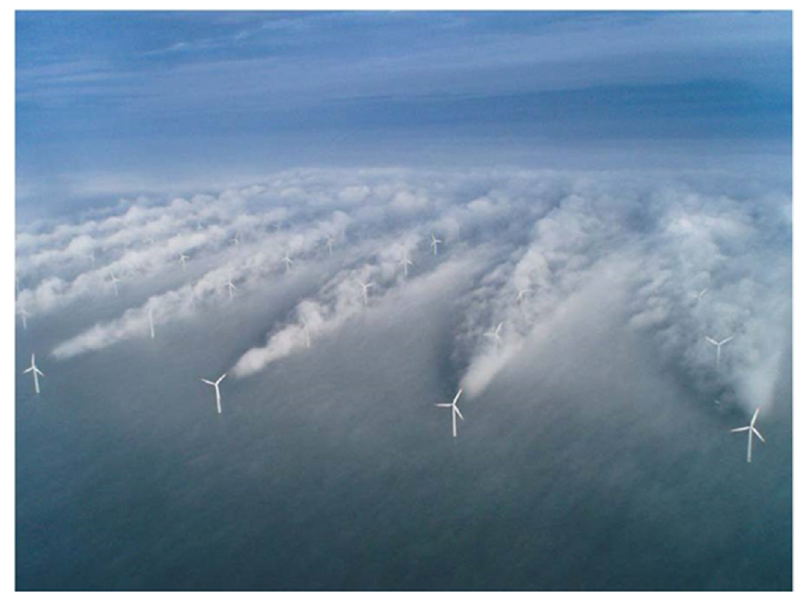
Figure A1. Image taken in February 2018 showing the obvious wake effects marked by humid air condensation in the Horns Rev OWF, Denmark.